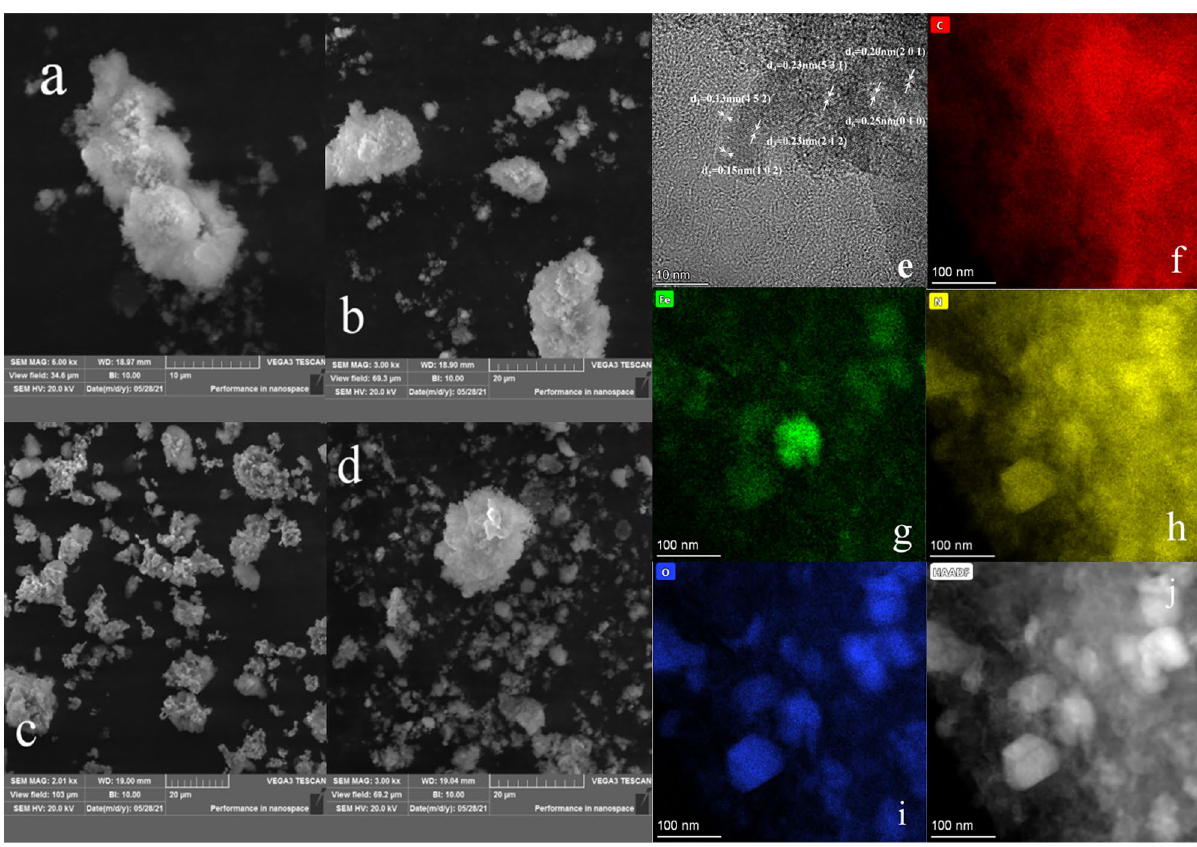
Figure 2. SEM, TEM and EDS testing of materials: ( a – d ) SEM image of NMC-2 adsorbent, ( e ) TEM image of NMC-2; ( g – i ) TEM-EDS spectrum of NMC-2, ( j ) TEM-EDS spectra of NMC-2 obtained from.